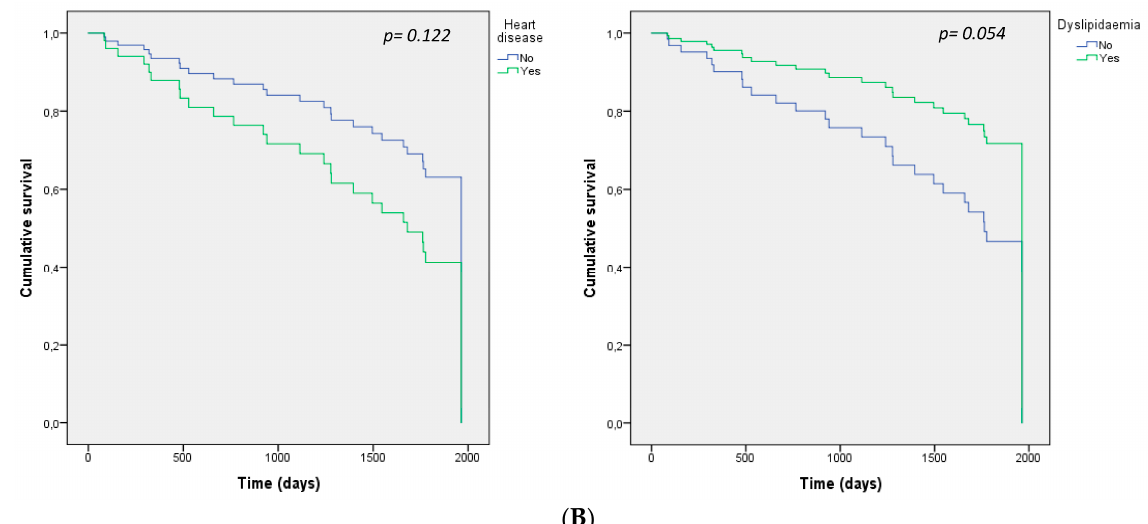
Figure 2. Cumulative survival of participants based on the presence of hypertension, diabetes, heart disease, or hyperlipidemia.